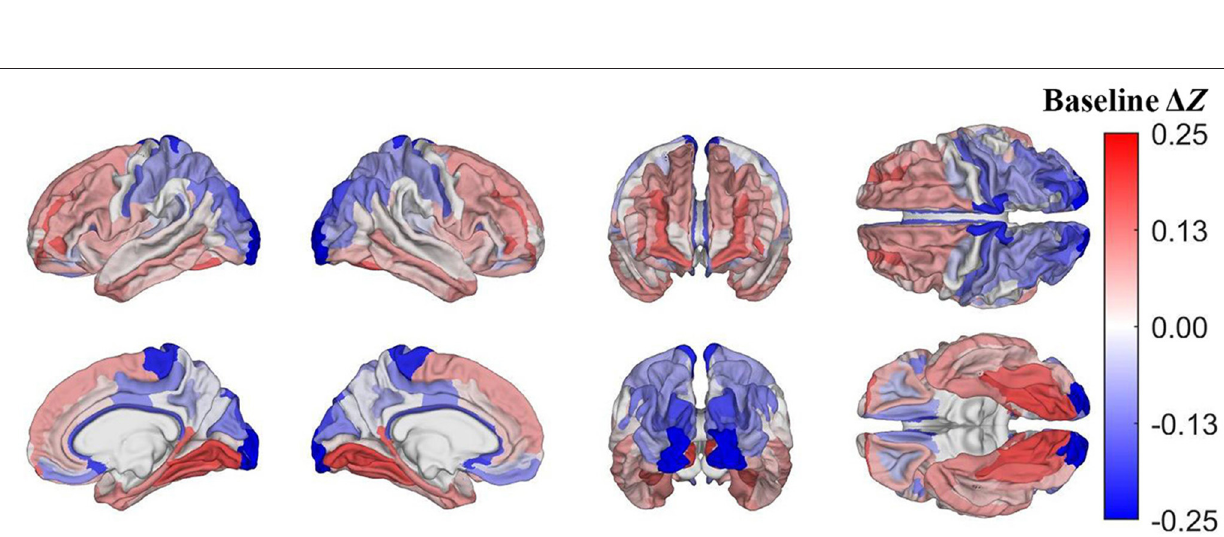
FIGURE 4 | Cortical map of differences in z -scores of cortical regions’ R values between mTBI and HC participants at baseline, corrected for multiple comparisons. Darker blue indicates that 1 z < 0, i.e., that a cortical region has a lower z -score in mTBI participants than in HCs. For example, at baseline, the occipital poles and paracentral lobules and sulci exhibit substantially lower z -scores in mTBI subjects than in